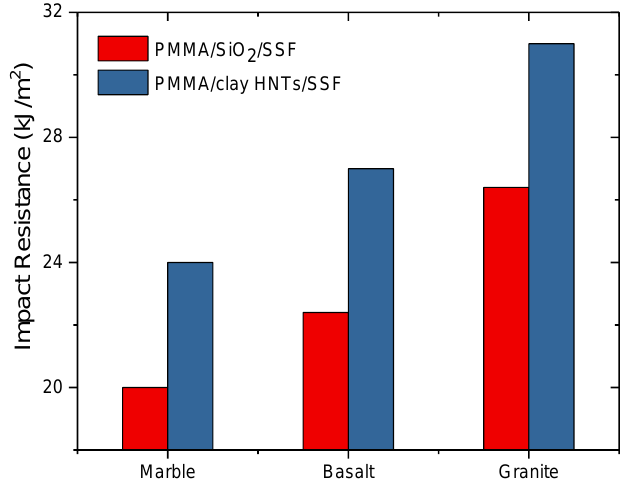
Figure 6. Effect of nanoparticle type on the impact strength of acrylic solid surface nanocomposite sheets.